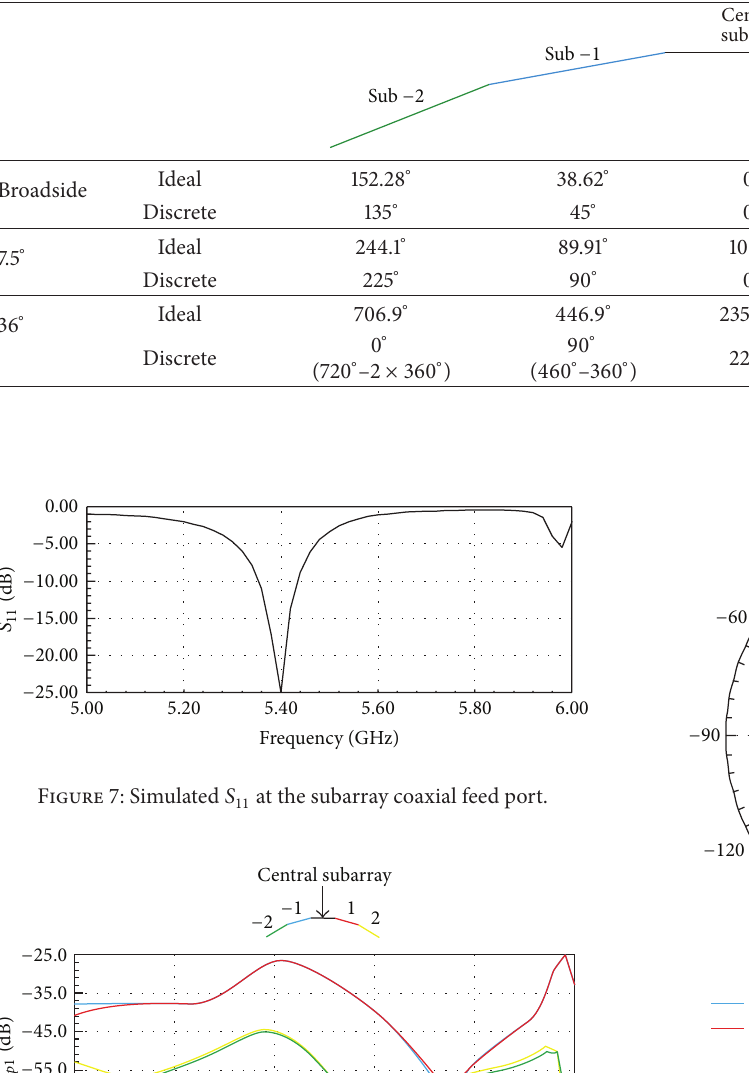
Figure 9: Simulated single subarray